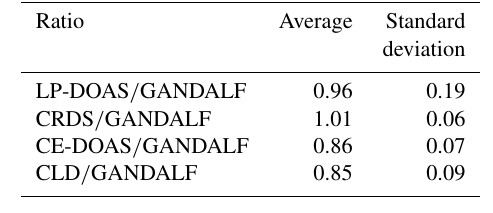
Table 4. Average values of NO 2 ratios during PARADE 2011. These are derived from the different overall NO 2 measurements with respect to GANDALF overall NO 2 measurement.